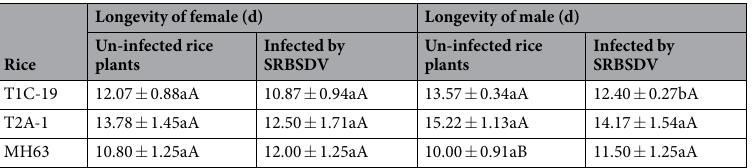
Table 9. Effects of transgenic rice plants infected with SRBSDV on the longevity of adult BPH.